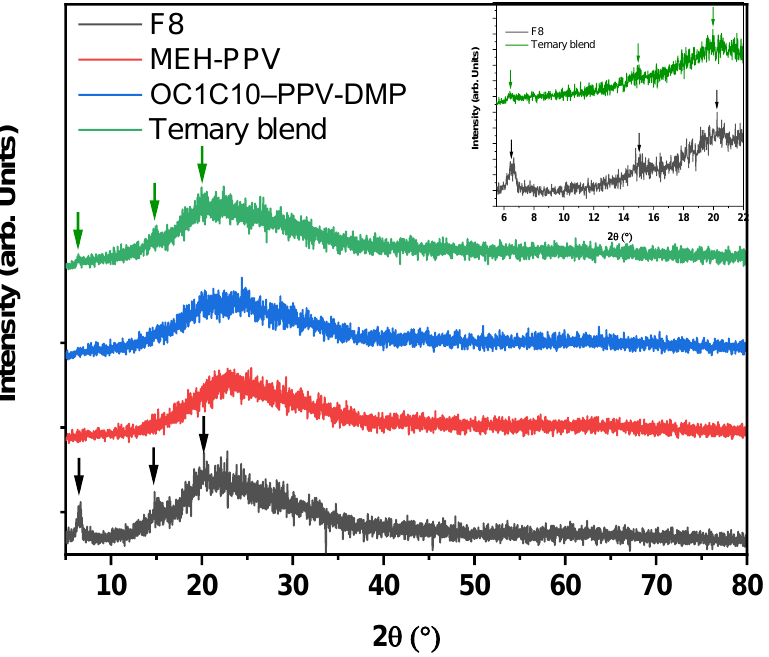
Figure 2. X-ray diffraction spectra of pristine F8, MEH-PPV, OC1C10-PPV-DMP and their ternary hybrid. The inset shows the narrow peaks in both F8 and ternary hybrid diffractograms. Figure 3 shows normalized absorption spectra of pristine thin films of F8, MEH-PPV, OC1C10-PPV-DMP and their optimal ternary hybrid. The maximum absorbance of F8, MEH-PPV and OC1C10-PPV-DMP was at 385, 507 and 500 nm, respectively. Both MEH-PPV and OC1C10-PPV-DMP have shoulders in the UV-region at 336 and 284 nm for MEH-PPV while they are at 337 and 276 nm for OC1C10-PPV-DMP. Upon incorporating both the acceptors into the donor to form the ternary blend, the main absorbance of F8 was red- shifted to 391 nm while the main absorbance of both acceptors was red-shifted to 512 nm and their shoulders to 294 nm. This finding may indicate the possibility of decreasing the optical band gap of the donor and thus increasing its conjugation length [24,30]. The cut-off wavelength of the donor absorbance edge also red-shifted from 444 nm to 450 nm in the ternary blend. The energy tail (E tail ) of the donor, which refers the expansion of tail depth states into the forbidden energy gap below the absorption edge, was decreased from 2.793 to 2.755 eV in the ternary blend while the steepness parameter ( σ ), which indicates the extension/shrinkage of the optical absorption edge due to the exciton–phonon or electron–phonon interactions, was increased from 0.00931 to 0.00943. The decrease in width of the localized tails of electronic states within the forbidden band gap of the donor can be expected from the decrease in the energy tail (E tail ) and the increase in the σ value